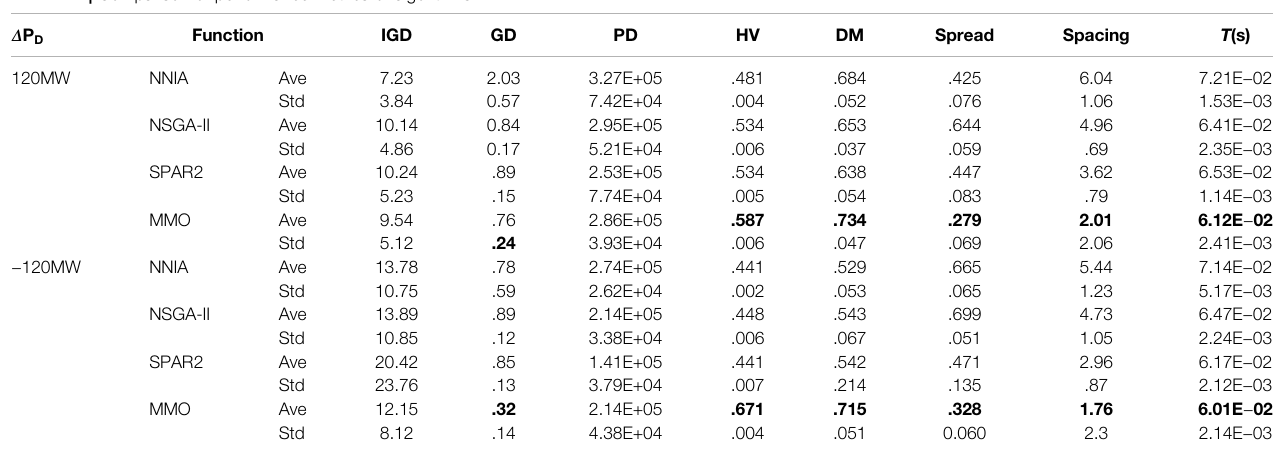
TABLE 4 | Comparison of performance metrics of